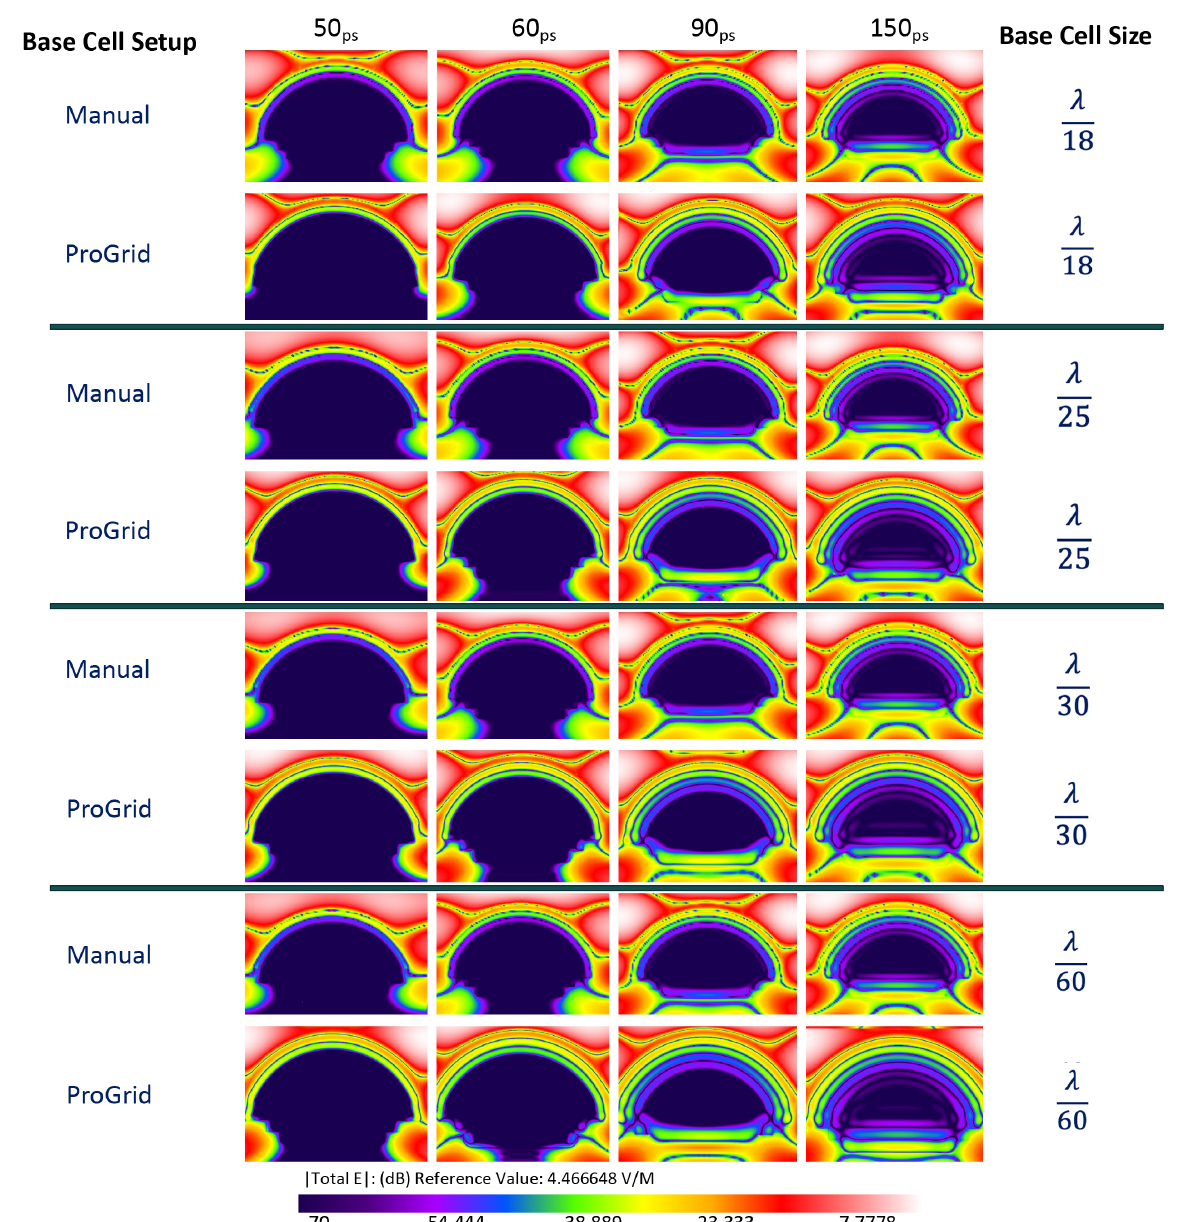
Figure 4. The output of planar E-field sensors for an EM source of 30GHz; the location of a planar E-field sensor placed vertically within the cornea. The simulation was carried out for λ /18 and λ /25, λ /30, and λ /60 using manual and PrOGrid